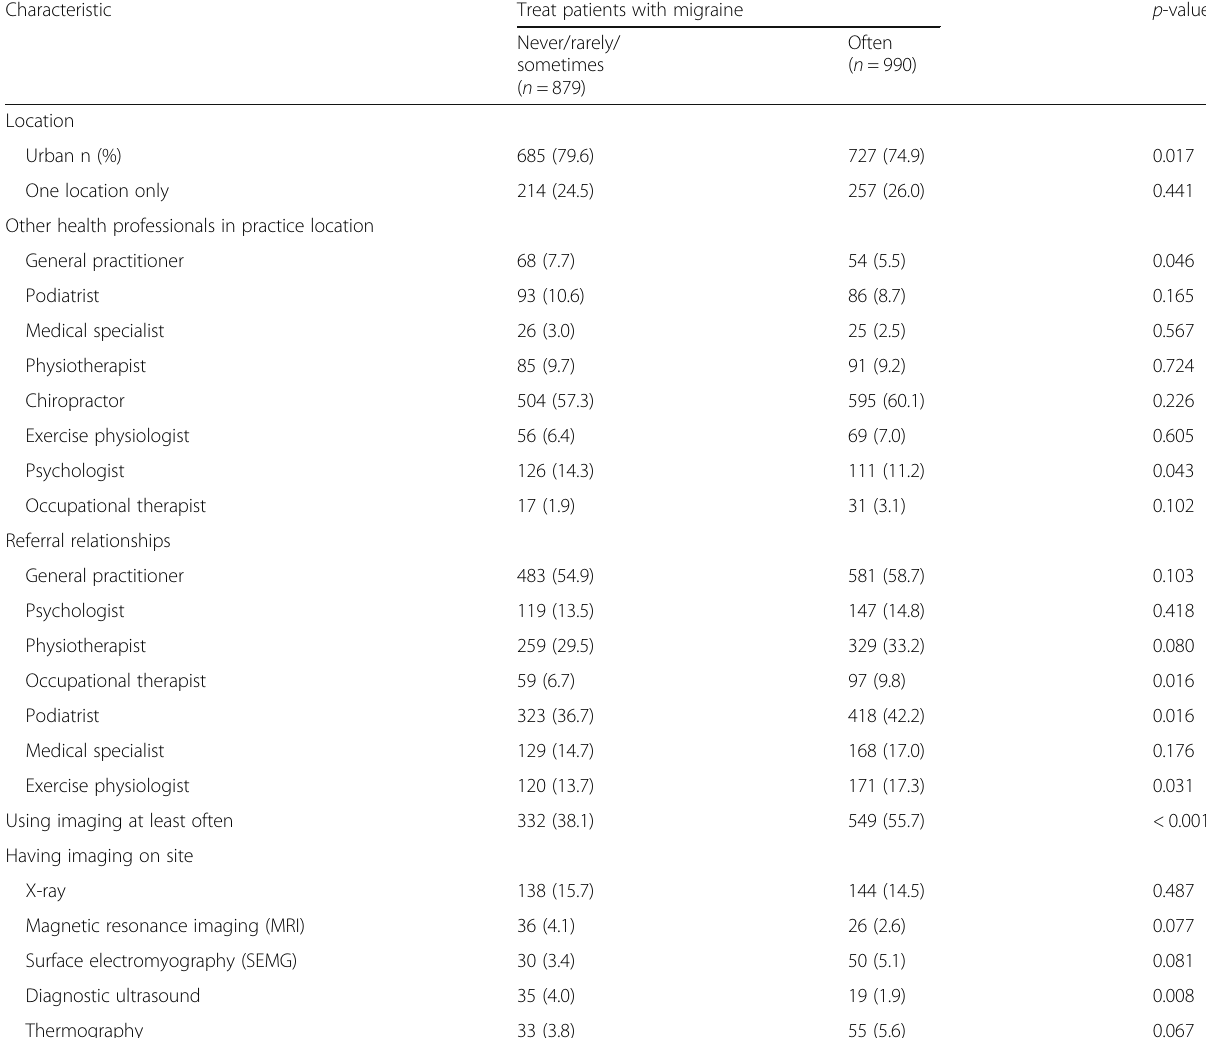
Table 2 Distribution of practice characteristics across frequency of practitioner treating patients with migraine